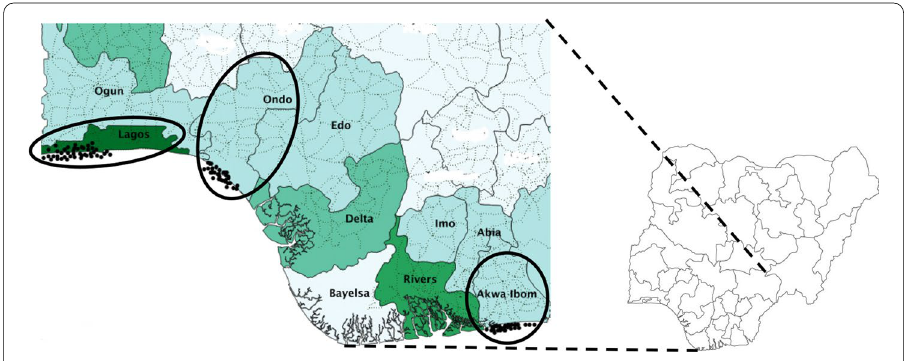
Fig. 1 Map of Nigeria showing shrimping communities and membership